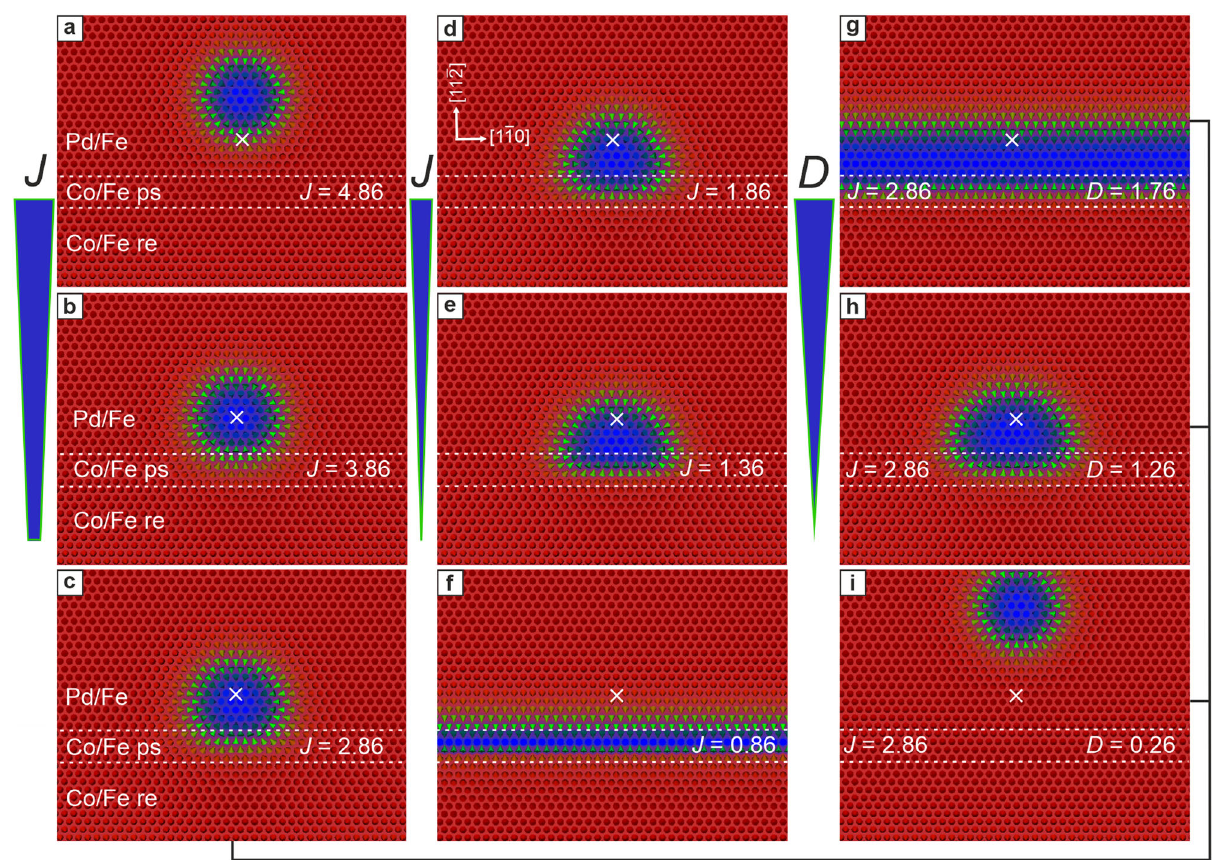
Fig. 6 Varying J and D in the pseudomorphic Co/Fe transition area. a – f Spin dynamics simulations with different values for the exchange interaction J and g – i the Dzyaloshinskii – Moriya interaction D in the pseudomorphic Co/Fe area. The hexagonal lattice is split in three distinct sections, as marked by the dashed lines, with different magnetic interaction parameters (Table 1) to represent the Pd/Fe bilayer and the pseudomorphic (ps) and reconstructed (re) Co/Fe bilayer. Red and blue areas represent spins pointing in opposite out-of-plane directions. In-plane pointing spins are visualized as green cones. Initially, the skyrmion was written at the position of the white cross. The displayed area was cut from a larger simulation area, see “ Simulation ” section of “ Methods ” . All simulations were performed at T = 0 K and B = 2 T.